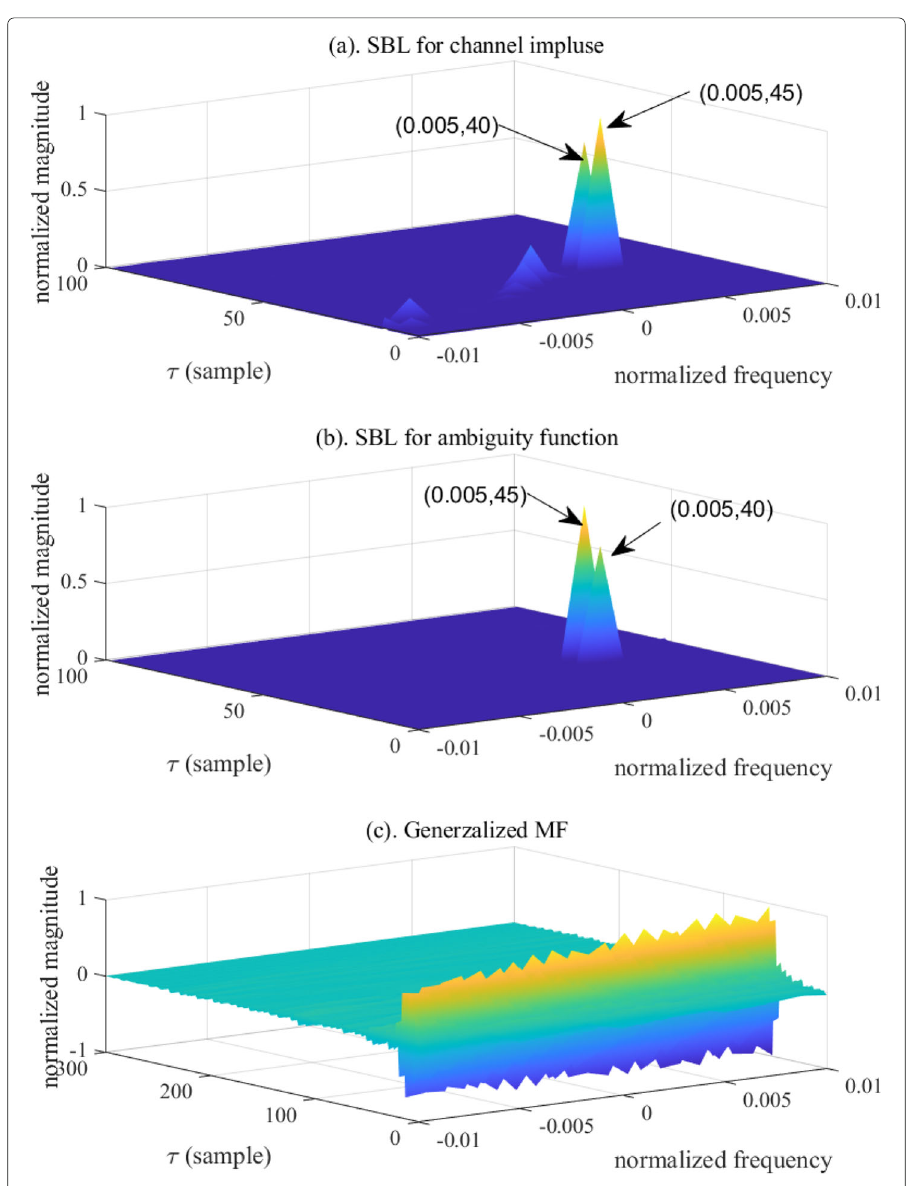
Fig. 6 2d estimation for